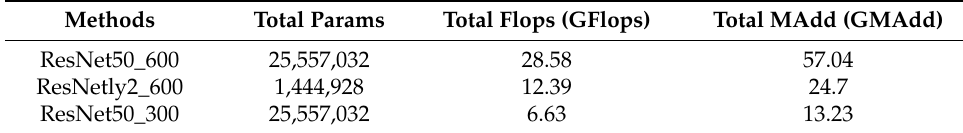
Table 1. Network calculations under different backbones and inputs.